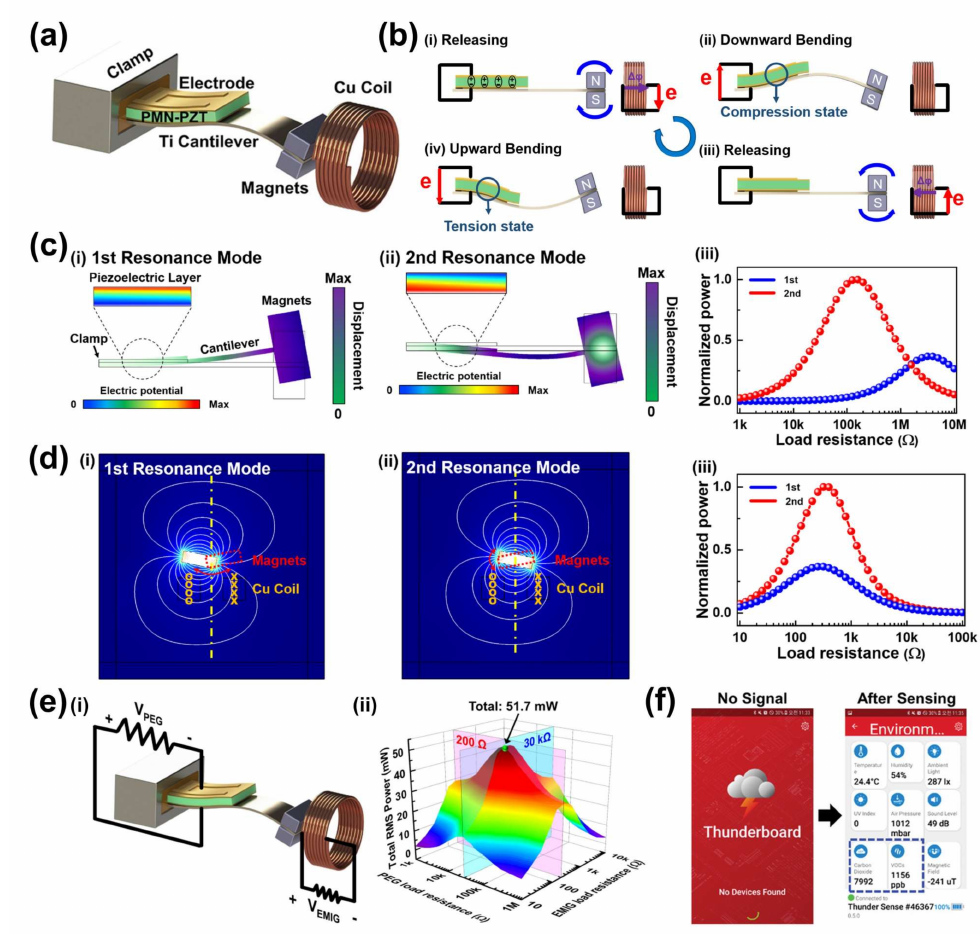
Figure 8. ( a ) Illustration of the hybridized MME generator. ( b ) Schematic illustration of the working mechanism of hybrid MME generator composed of piezoelectric and electromagnetic induction parts. Theoretical MME simulation results of the 1st and 2nd resonance bending modes for piezoelectric part ( c ) and electromagnetic induction part ( d ). ( e ) Circuit configuration for the hybrid MME generator to characterize RMS power with the impedance matching condition ( i ) and total RMS power of the hybrid MME generator with the impedance matching condition ( ii ). ( f ) Snapshot images of IoT monitoring system operated by hybrid MME generator. Reproduced with permission